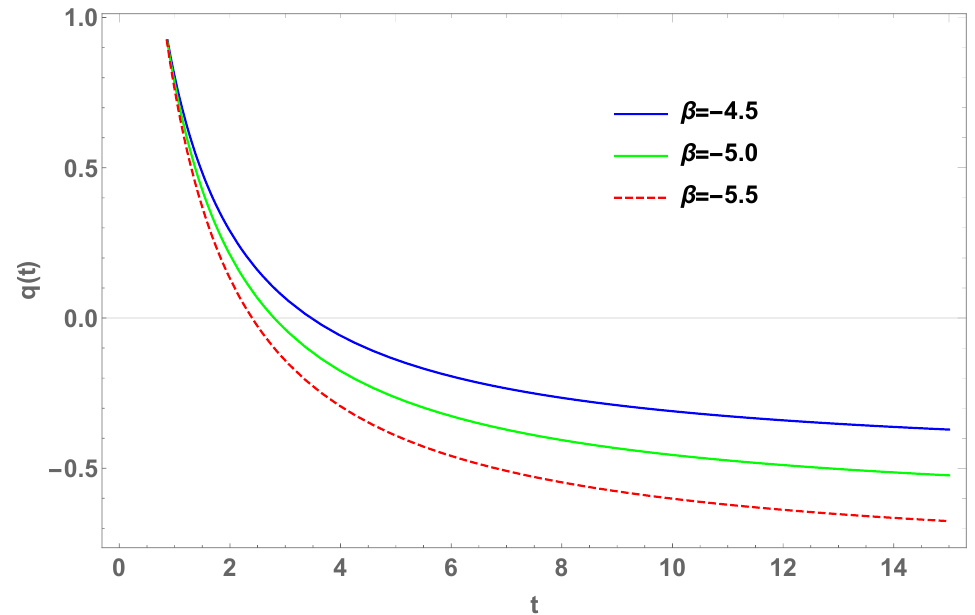
Figure 3. Behaviour of the deceleration parameter ( q ) with respect to cosmic time t for different values of β with α = − 1.5, b = 0.2.